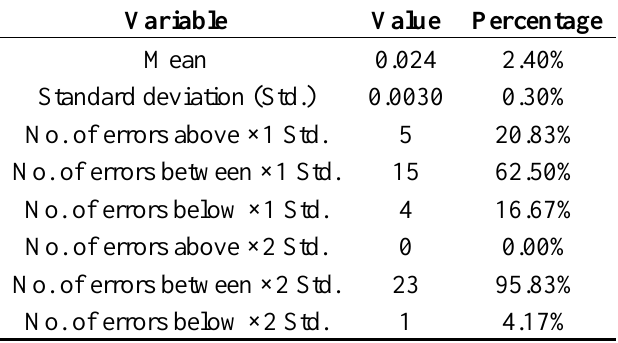
Table 2. Error distribution per